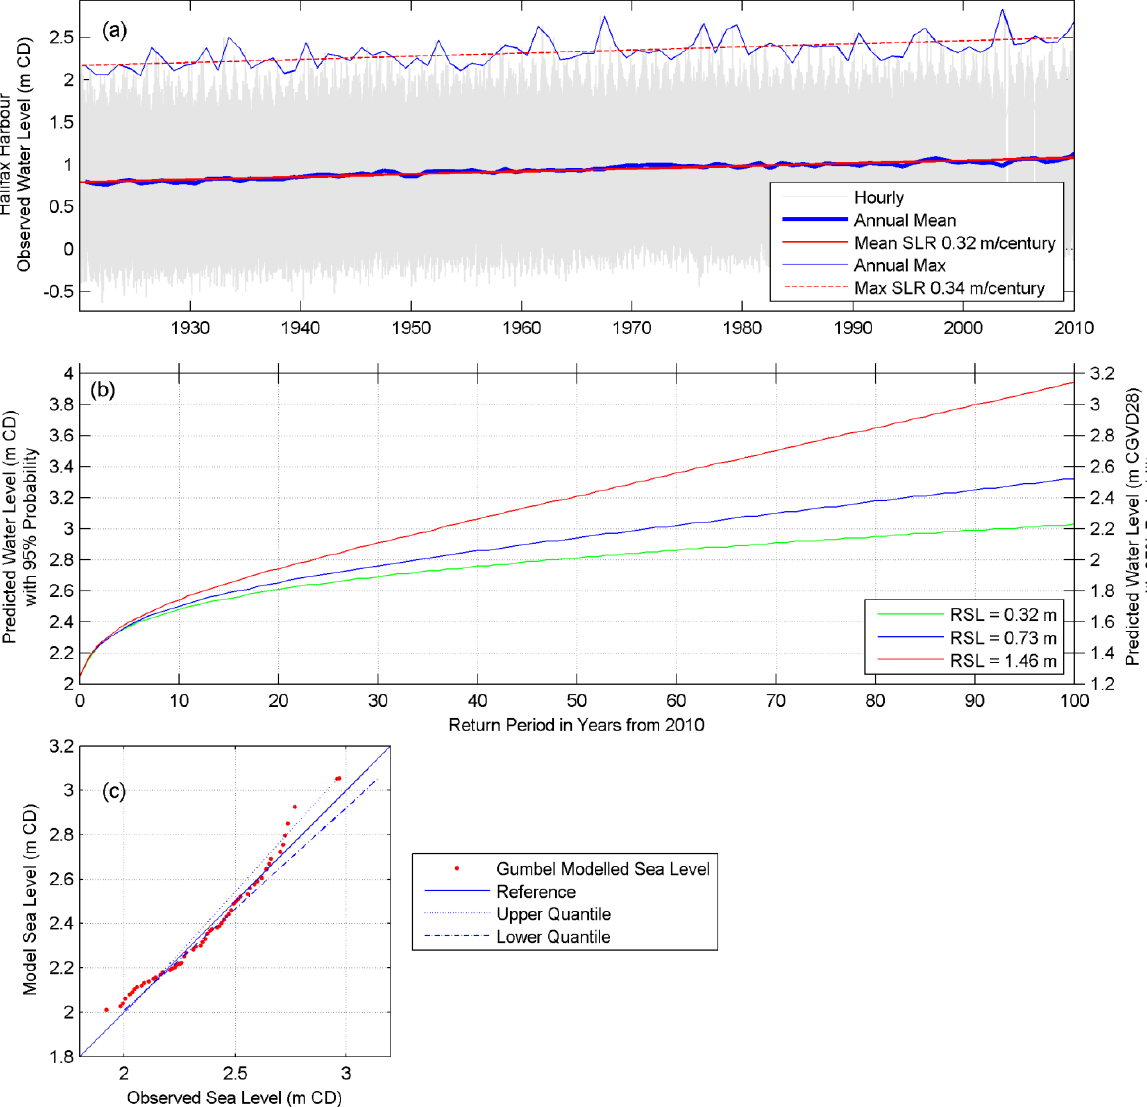
Figure 6b shows water levels referenced to CD on the left vertical axis and referenced to CGVD28 on the right vertical axis. The 100 year flood level under current RSL conditions is 2.2 m, which is 10